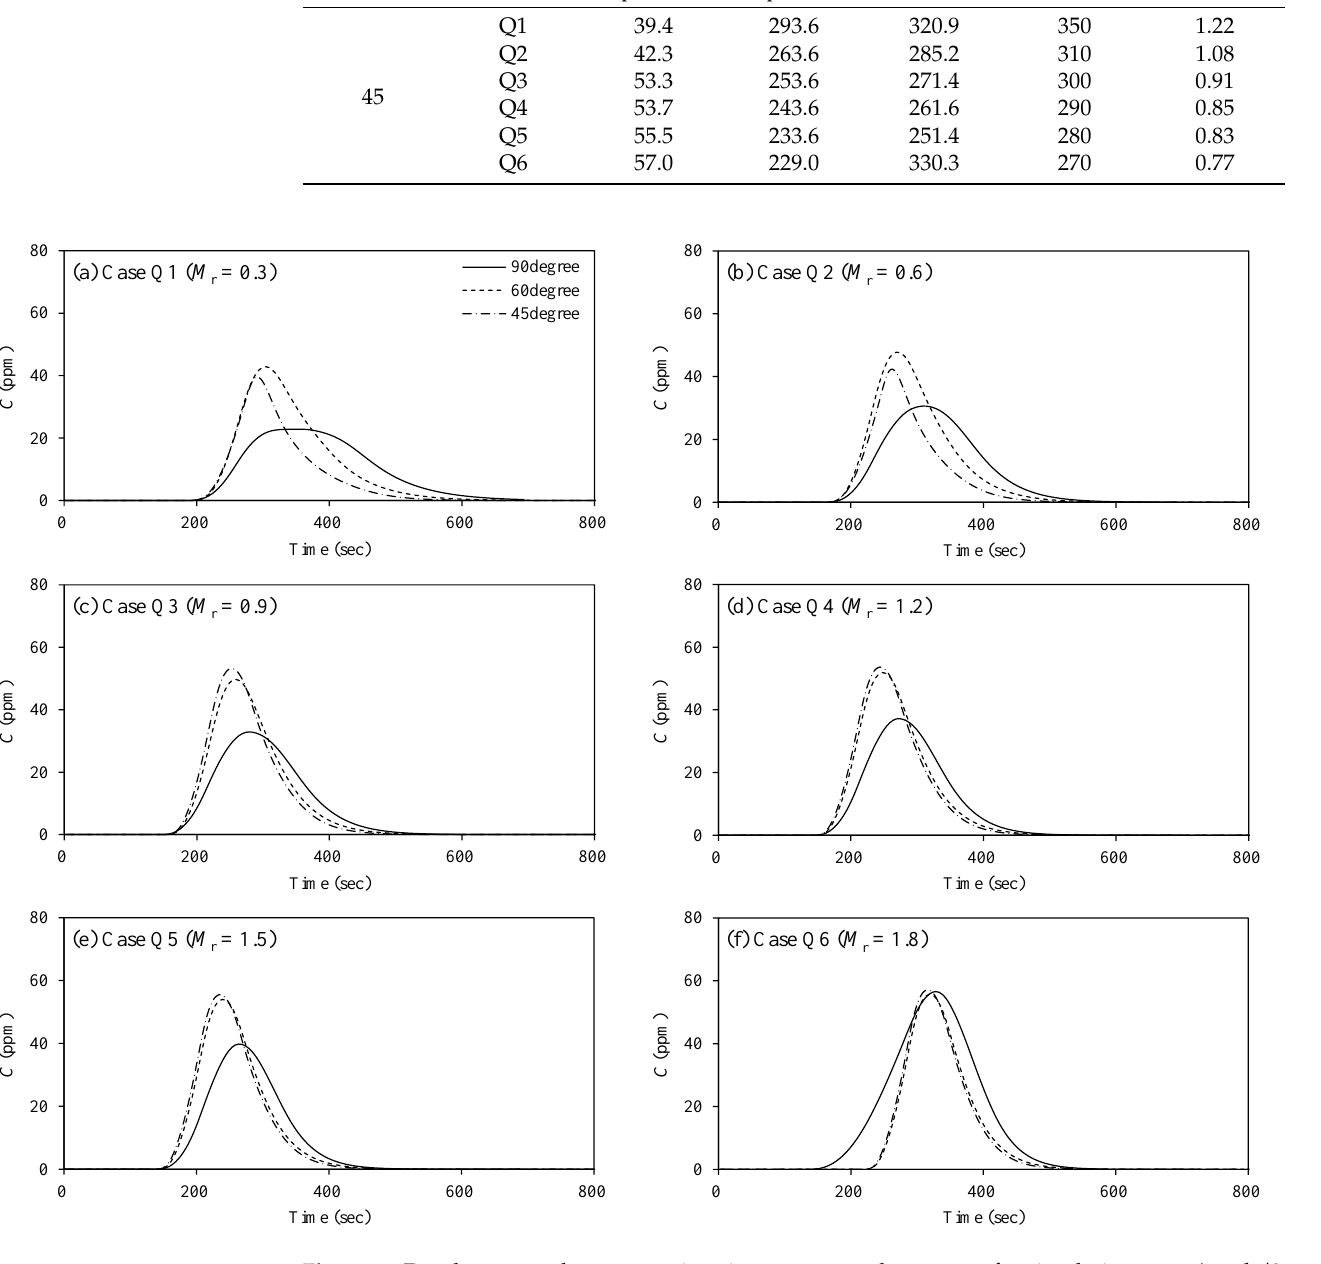
Figure 9. Depth-averaged concentration-time curves at the center of recirculation zone ( x = l s /2, y = b s /2). Table 2. Statistical properties of C-t curves at x = l s /2, y = b s /2 ( C p : peak concentration; t p : time for occurrence of C p ; μ t : centroid of the C-t curve; t d : retention time of the contaminated water; ξ t : Skew- ness coefficient).